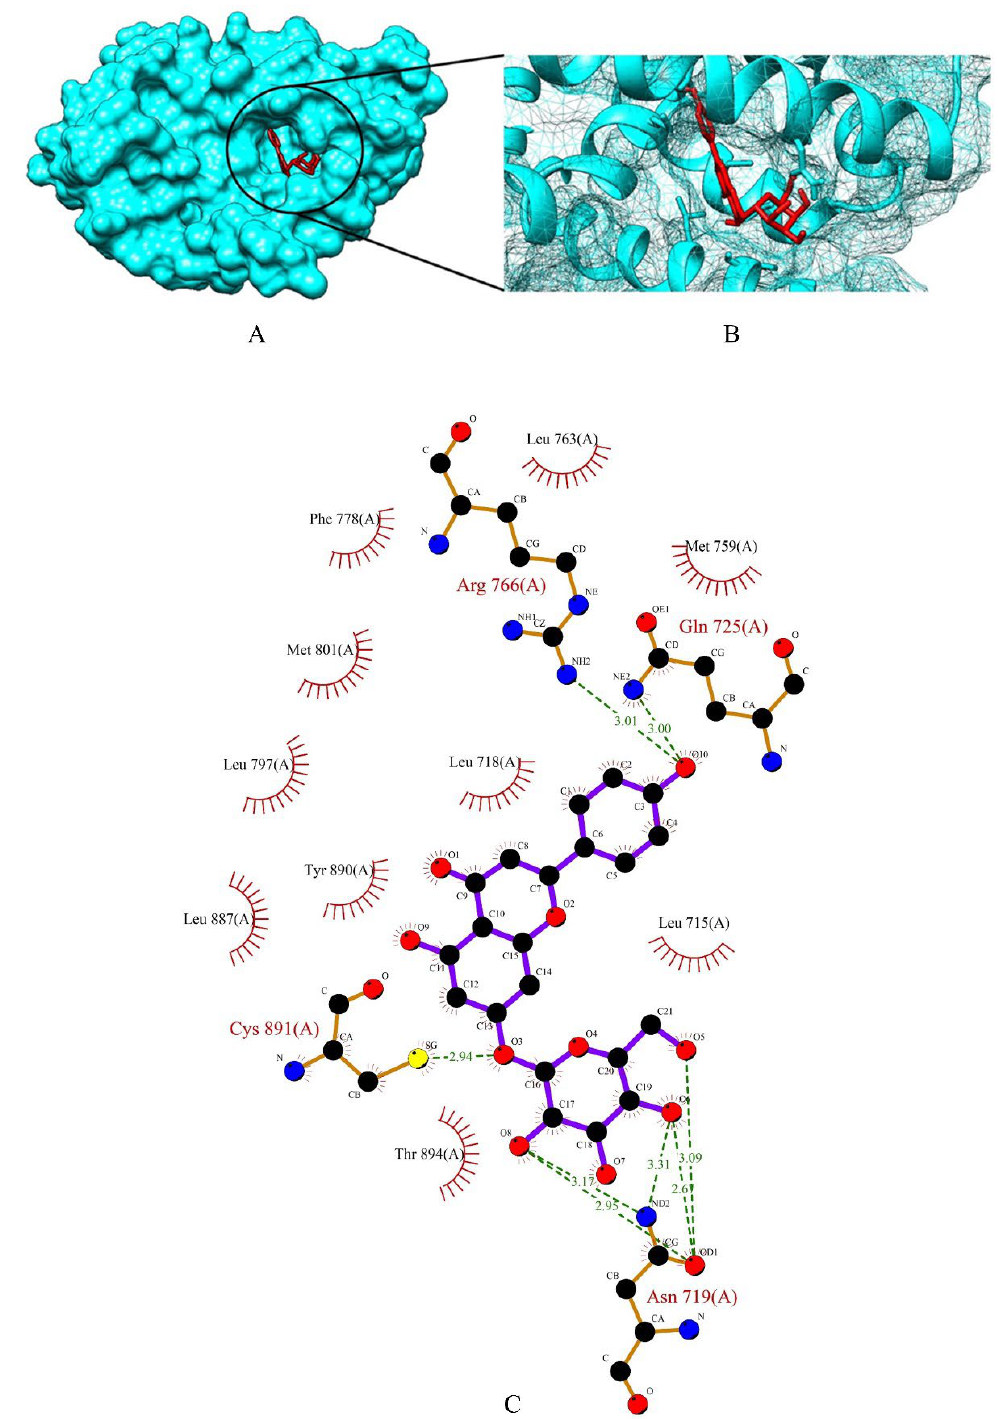
Figure 6. ( A ) Surface view of apigetrin-PR binding complex. ( B ) Binding pose of apigetrin. ( C ) Vi- sualization of the docked complex with ligplot + shows the binding interaction of apigetrin with PR. Eight hydrogen bond interactions (green dotted lines) were formed between apigetrin and four amino acid residues (Asn 719, Gln 725, Arg 766, Cys 891) of target protein PR.